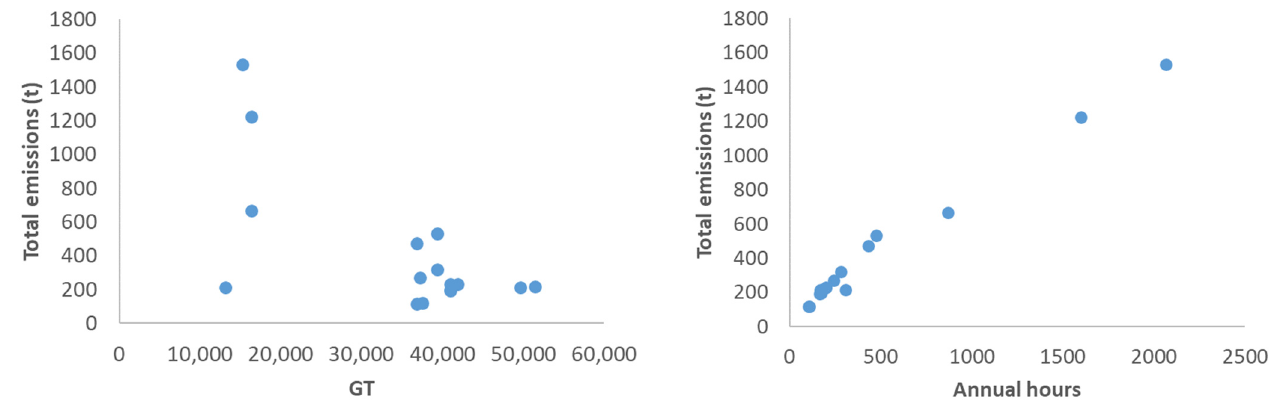
Figure 6. Influence analysis of the time for hoteling ( T h ) and GT in the emissions calculation.